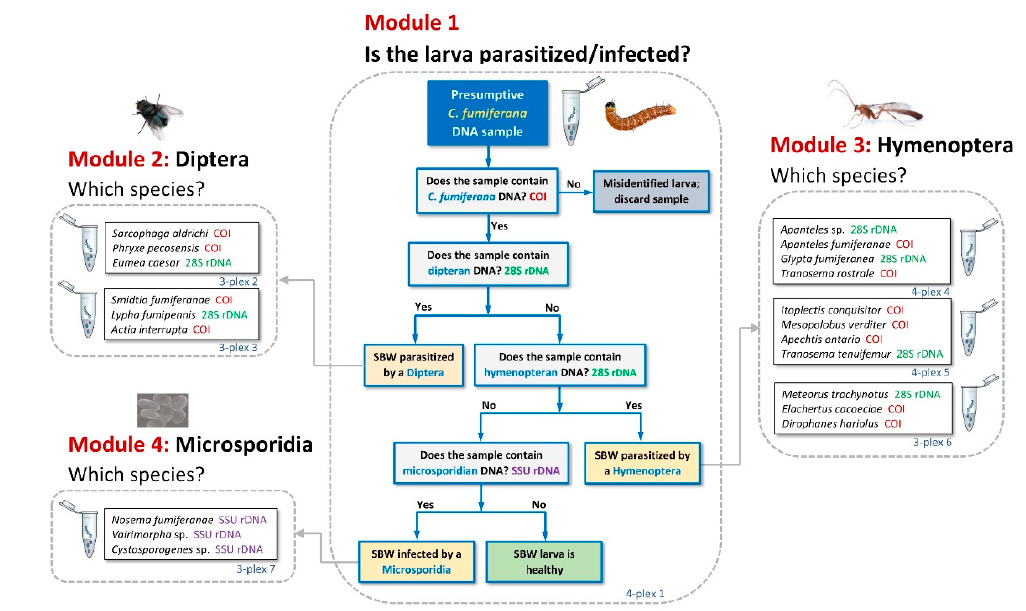
Figure 2. Architecture of the molecular sorting tool. DNA samples are first processed through Module 1 to determine whether the host was correctly identified and to detect the presence of dipteran, hymenopteran, and/or microsporidian DNA in the sample. For the purpose of illustrating the sorting strategy of our tool, the four assays included in Module 1 are here presented as sequentially processed steps; however, all four “questions” answered by this 4-plex assay are addressed simultaneously and can yield parallel positive amplifications (see Figure 3 for an example). Depending on the outcome of Module 1 analysis, the DNA sample can be further processed through Modules 2, 3, and/or 4 to identify the dipteran, hymenopteran, and/or microsporidian species detected, respectively. These modules comprise one (Module 4), two (Module 2), or three (Module 3) multiplex assays (Table 2), altogether enabling the identification of 20 natural enemies of the spruce